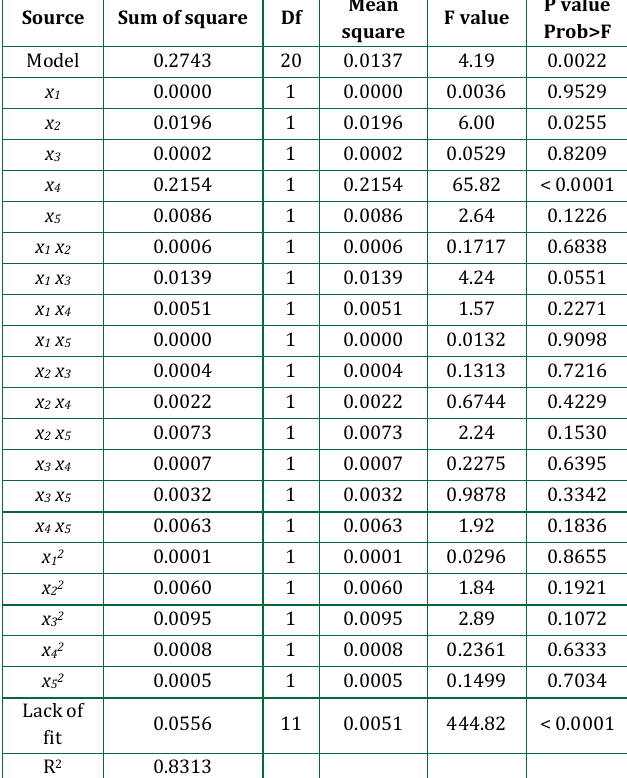
Table 3: Model analysis data for the moisture ratio response variables for the fluidized bed